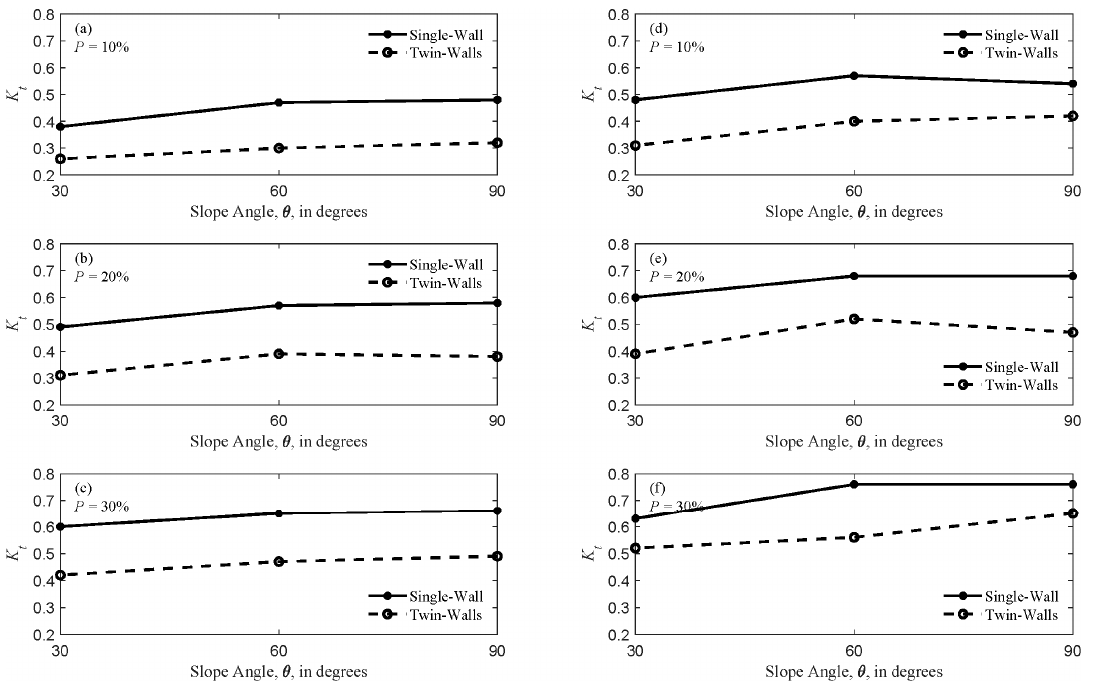
Figure 5. Variation of K t with θ for d / L p = 0.2733 and different porosities and wall configurations. On the left, H is / d = 0.2493 ( a , b , and c ) and on the right H is / d = 0.1284 ( d , e , and f ).